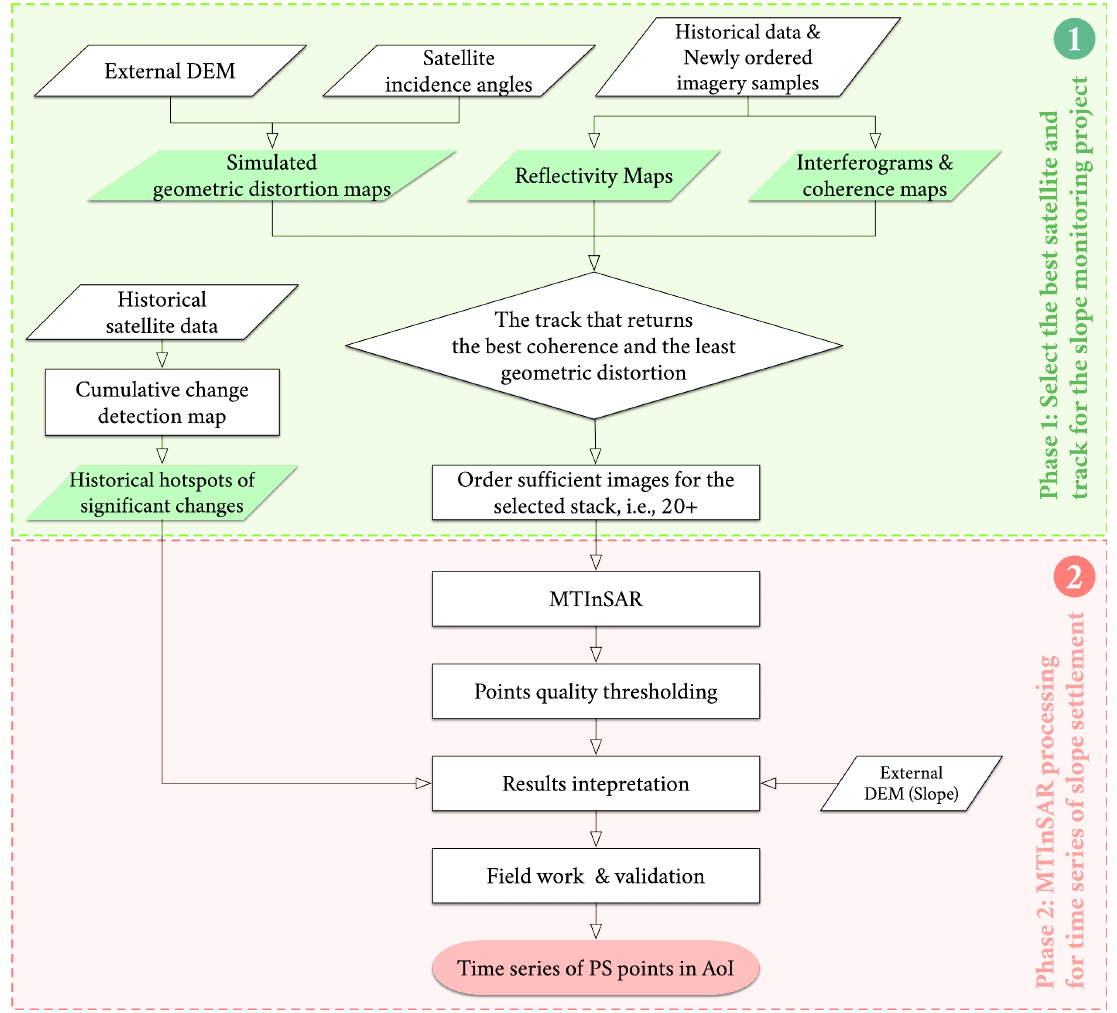
Figure 1. The workflow of the two